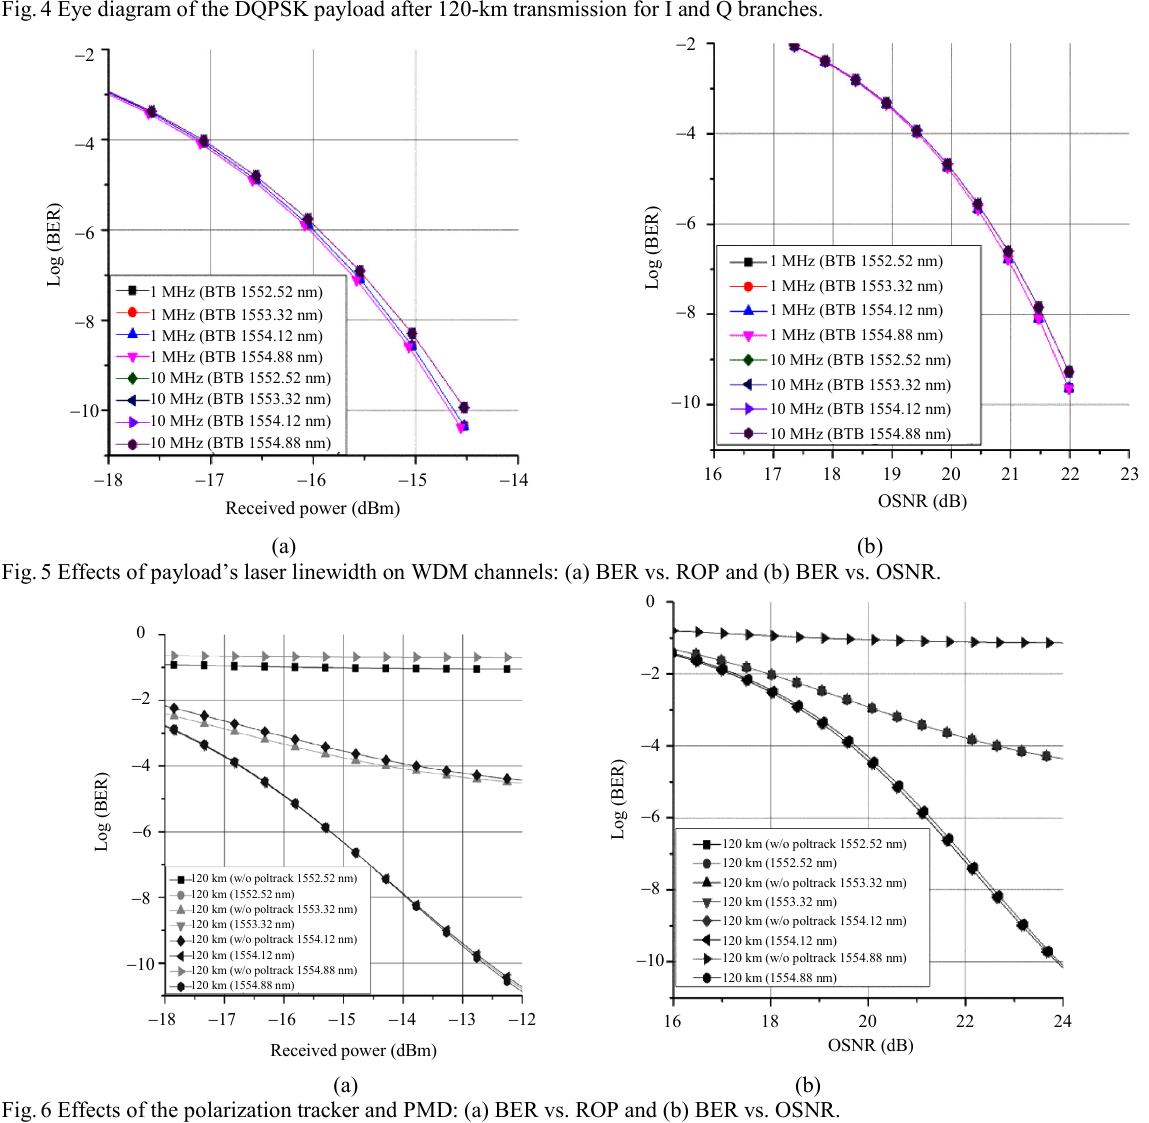
Fig. 6 Effects of the polarization tracker and PMD: (a) BER vs. ROP and (b) BER vs.